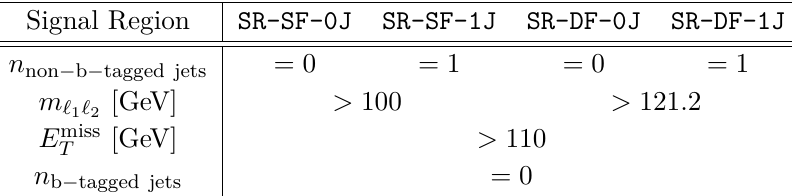
search. We do not consider the cut by T